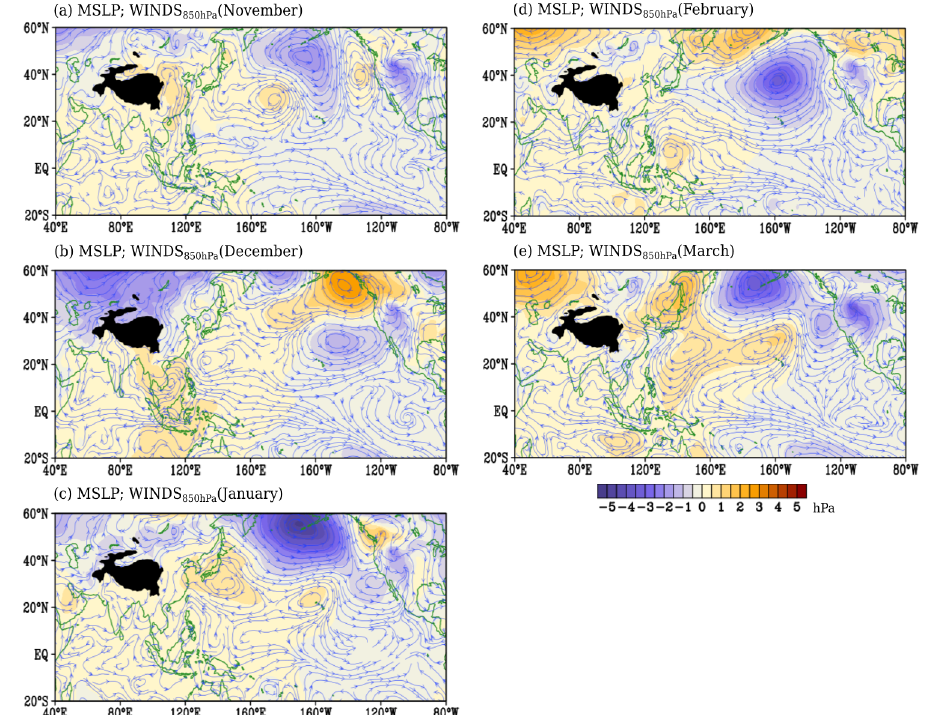
Figure 15. Composite anomalies of the mean sea level pressure (MSLP; shading; hPa) and 850 ‐ hPa winds ( WINDS 850hPa ; streamlines; m s –1 ) during E2 for ( a ) November; ( b ) December; ( c ) January; ( d ) February; and ( e ) March. The anomalies are the deviations from the long ‐ term means (1961–2008).